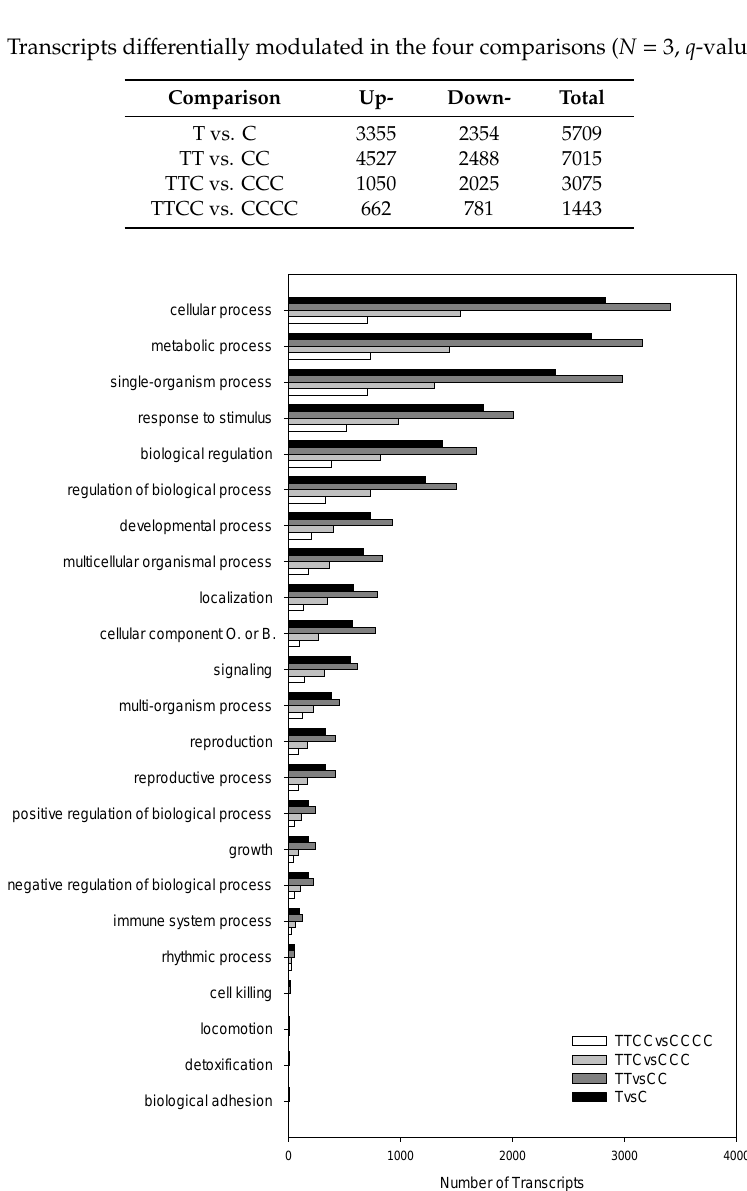
Figure 3. Enrichment analyses of biological process categories (gene ontology (GO) terms) of differentially modulated transcripts in four comparisons. Black bars refer to T vs . C; dark grey bars refer to TT vs . CC; light grey bars refer to TTC vs . CCC; white bars refer to TTCC vs. CCCC ( N = 3, q -value < 0.05).